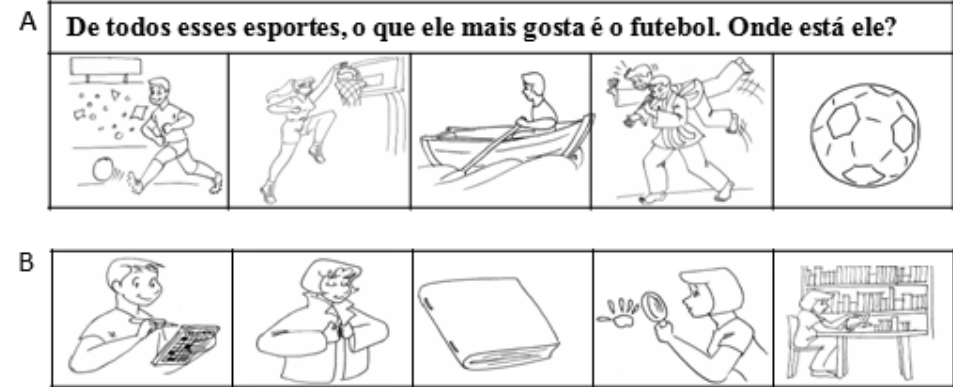
Figure 2. Examples of items from Reading Comprehension (A) and Listening Comprehension (B) subtests of the CTLRC. In A, the sentence to be read is “Of all these sports, what he likes most is soccer. Where is it?” In B, the sentence to be listened is “The woman is studying in the